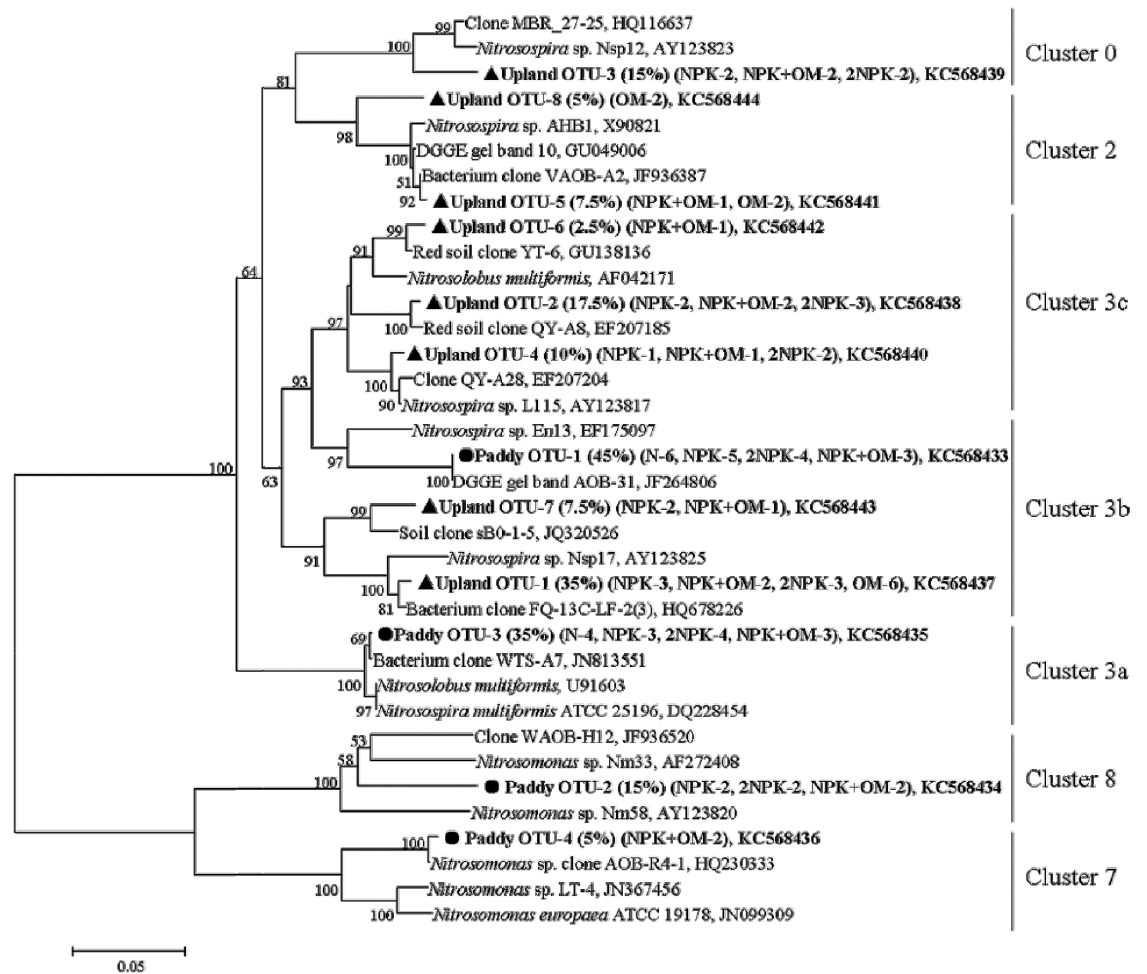
Fig. 4. Neighbor-joining tree showing the relationship of bacterial amoA genes retrieved from the clone library of upland and paddy soils to those in GenBank. The scale bar indicates 5 changes per 100 nucleotide acid positions. Bootstrap values ( > 40%) are indicated at branch points. Sequences from this study are shown in bold. N represents the OTU derived from upland soil, and • represents the OTU derived from paddy soil. Table 2. Diversity indices based on DGGE profiles of amoA gene